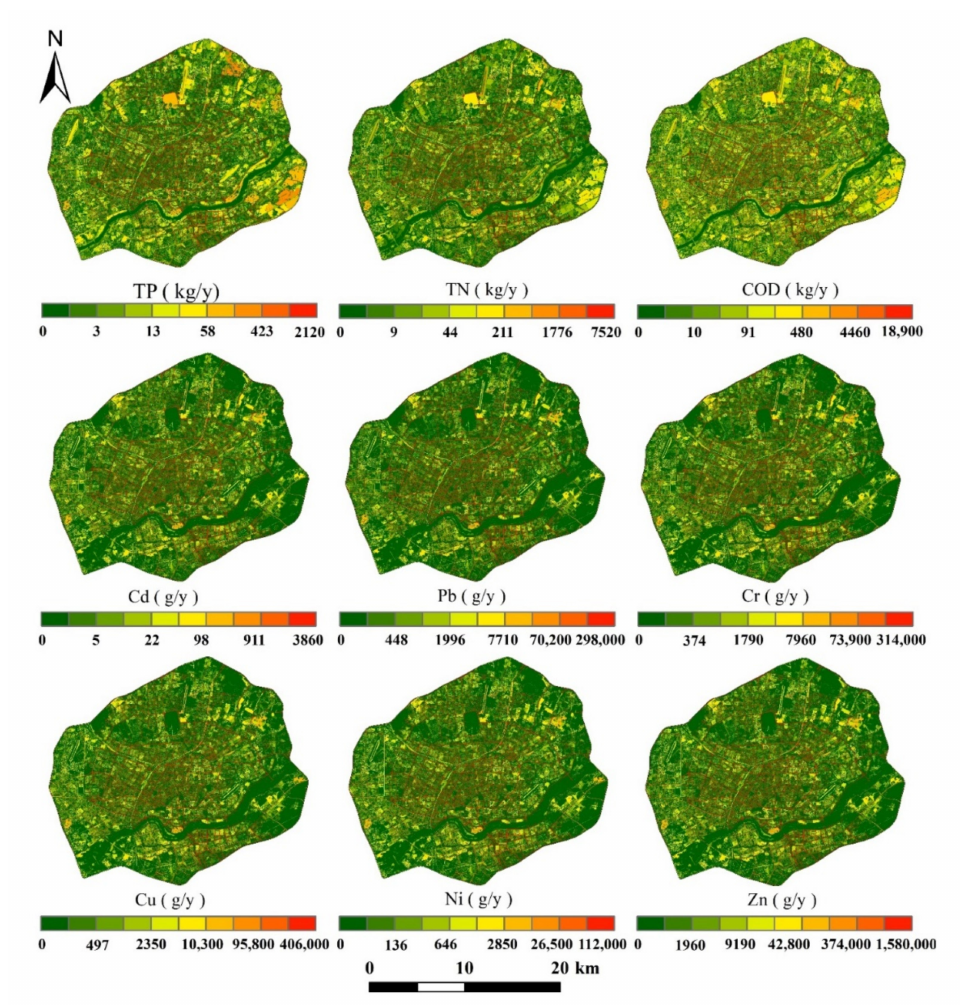
Figure 11. The spatial distribution of total phosphorus (TP), total nitrogen (TN), chemical oxygen demand (COD) and six heavy metals (Cd, Pb, Cr, Cu, Ni, and Zn) loads in the built-up area of Shenyang